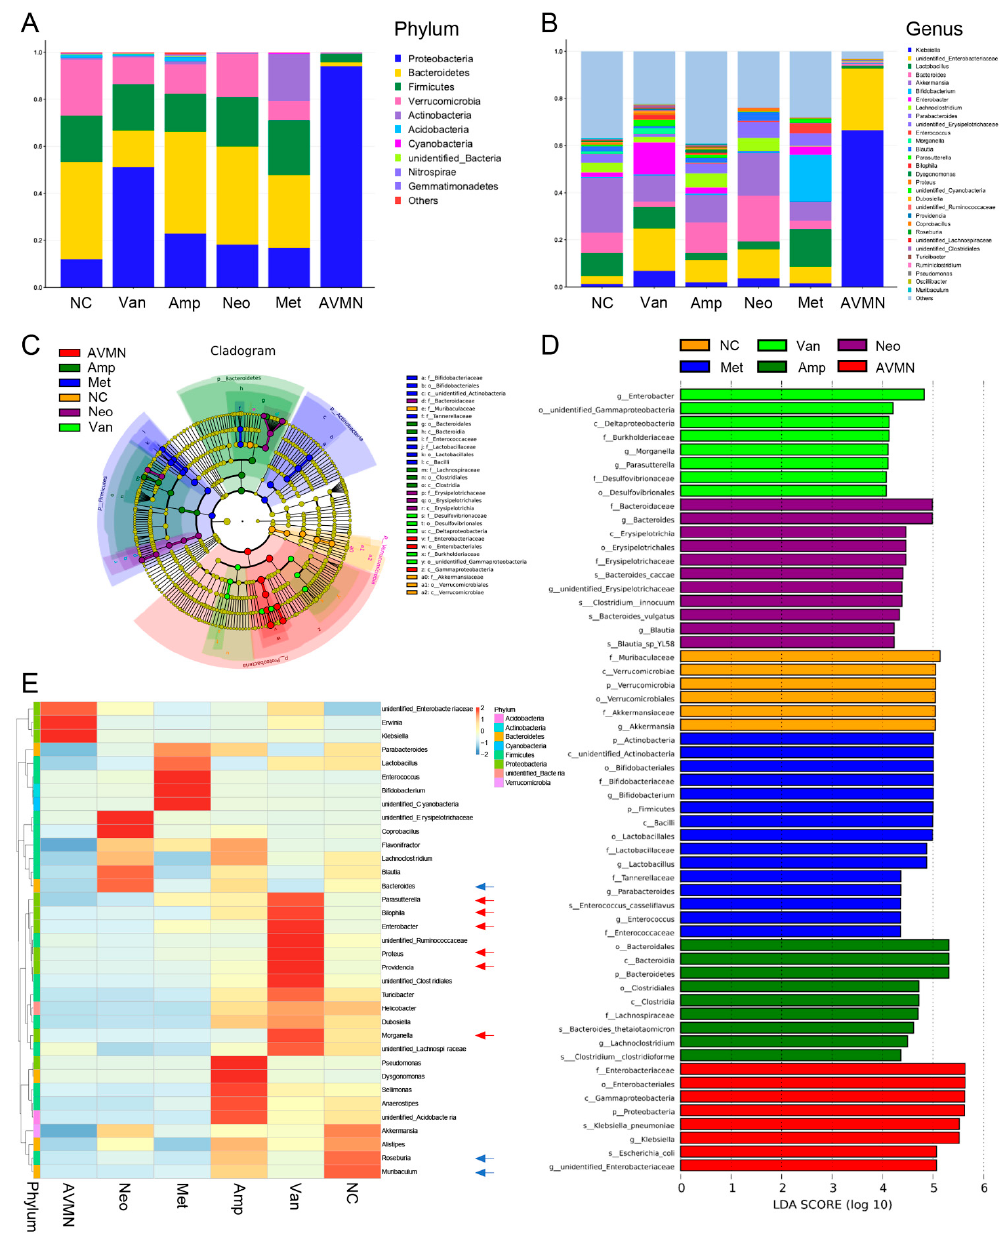
Figure 3. Vancomycin treatment improves the taxonomic composition of the gut microbiota in mice. ( A , B ) Bar plots displaying average relative abundance of prevalent microbiota at phylum level ( A ) and genus level ( B ) in the six groups studied. ( C ) Taxonomic cladogram obtained from LEfSe analysis showing bacterial taxa (family, class, order) that was differentially abundant among six groups of mice. Each node represents a specific taxonomic type. Each color represents mice treated with the same antibiotic. ( D ) Results of LEfSe analysis showing bacterial taxa that were significantly different in abundance among all groups. The criteria for feature selection are LDA score (log10) > 4. p, phylum; c, class; o, order; f, family; g, genus. ( E ) Heatmap of selected most differentially abundant features at the genus level in each group. The blue color represents less abundant; lighter yellow color represents intermediate abundance; and red represents the most abundant. The red arrow indicates the bacteria enriched, and the blue arrow indicates low abundance of bacteria in the Van group compared with the other five groups. NC, n = 6; Van, n = 6; Amp, n = 7; Neo, n = 5; Met, n = 5; AVMN, n =